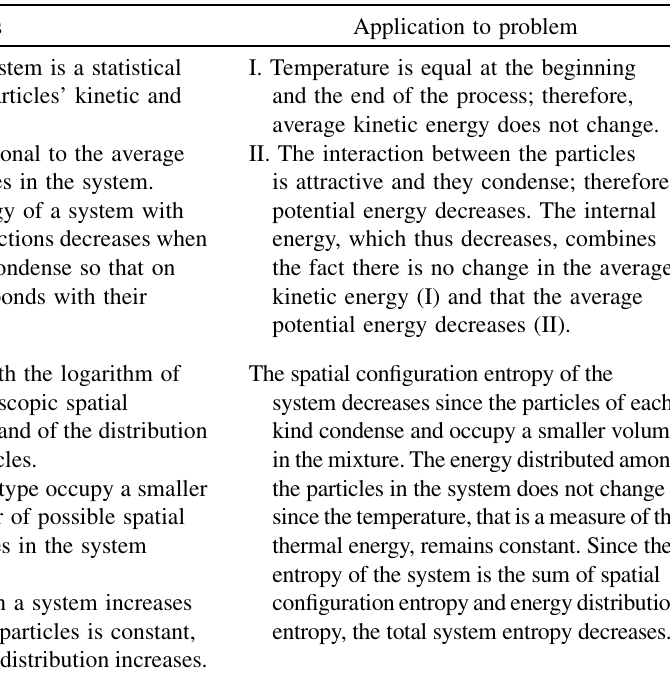
TABLE III. Resources needed for proper solution of the phase separation problem. Resources Application to